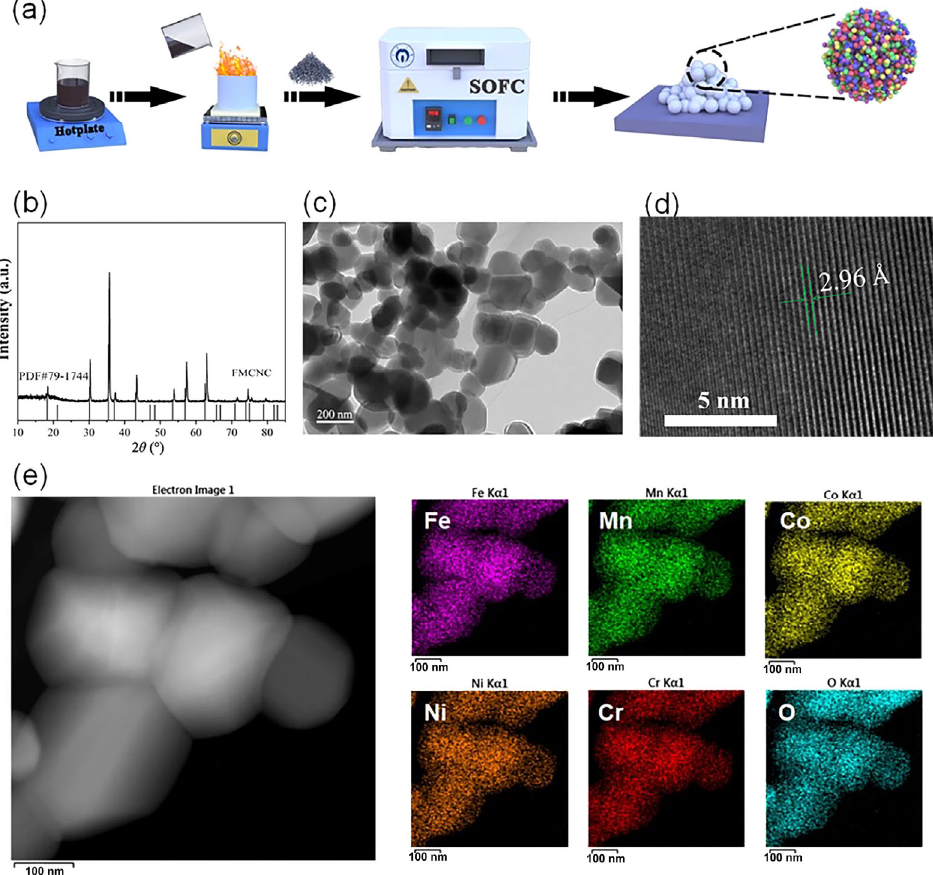
Fig. 1 (a) Scheme for the preparation of FMCNC powder; (b) XRD pattern with the reference PDF#79-1744; (c) TEM and (d) HRTEM images for the synthesized FMCNC; (e) HADDF images of the FMCNC powder with the distribution of